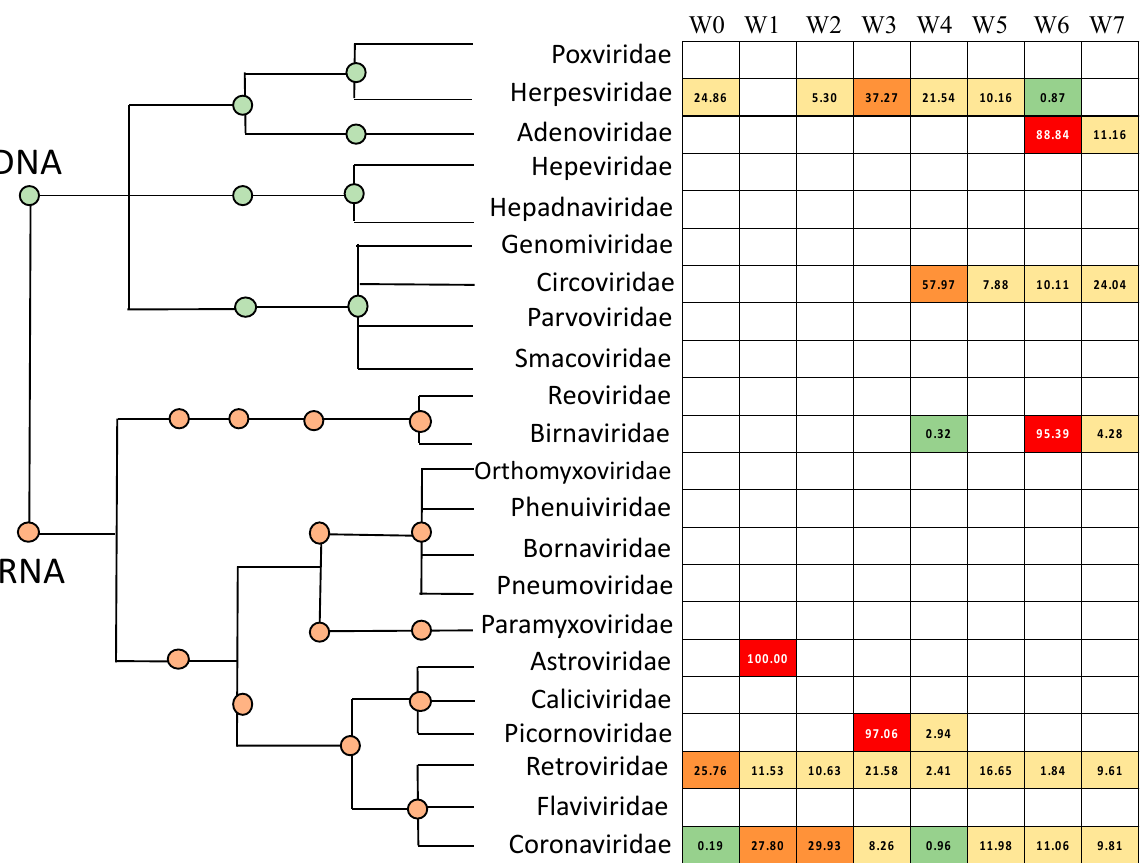
Figure 3. Heat map with phylogenetic tree representing the detection intensity of each eukaryotic viral family from hatching to processing. Color intensity corresponds to the range of relative abundance of each family from 0 to 100%. The sum of each row, or viral family, is 100%.